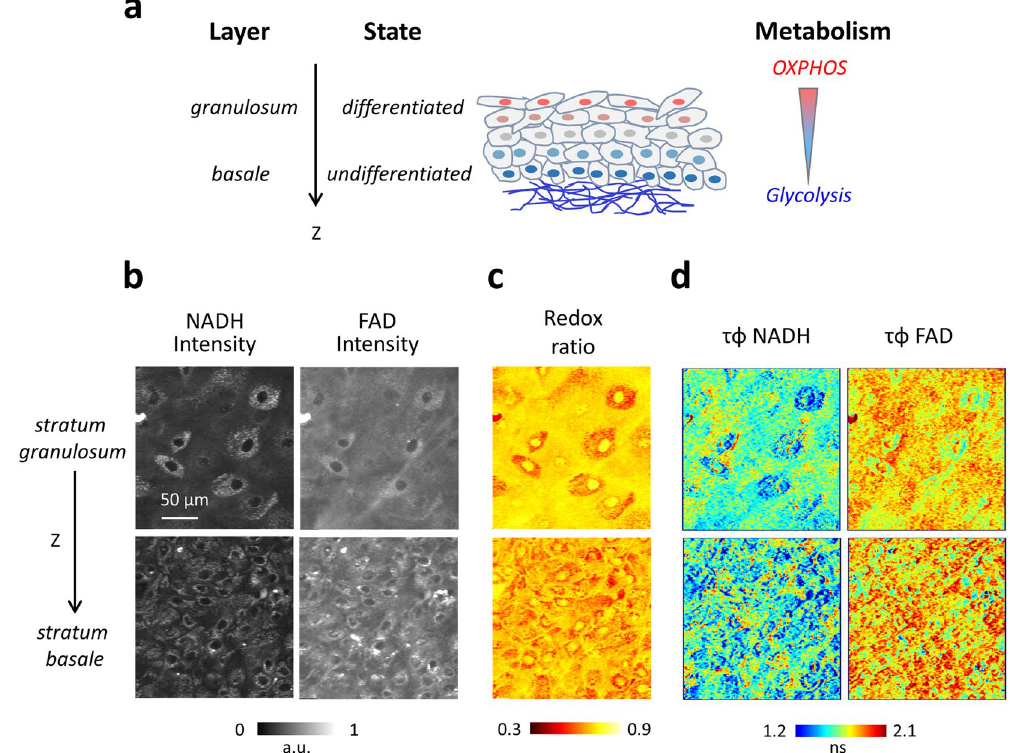
Figure 2. Simultaneous multiphoton FLIM imaging of NADH and FAD reveals a metabolic gradient in redox ratio and lifetime in reconstructed human skin associated with cell differentiation ( a ) Three-dimensional scheme of reconstructed human skin. Proliferating cells are located at the basal layer, right above the dermis, while differentiated cells are located on different layers above the basal layer. A metabolic gradient along the z-depth of the epidermis goes from an energetic metabolism dominated by glycolysis in the basal cells to one dominated by OXPHOS in the differentiated cells. ( b ) NADH and FAD intensities are acquired simultaneously at different depths of the epidermis. Two representative images are shown at two different depths within stratum basale and stratum granulosum . ( c ) Intensity redox ratio FAD/(NADH + FAD), calculated simultaneously from NADH and FAD intensities reveals heterogeneity within single planes and a z-gradient associated with cell differentiation. ( d ) NADH and FAD lifetime along the z-depth reveals a gradient associated with cell differentiation. Time per pixel, 160 µ s. Triplicate experiments were